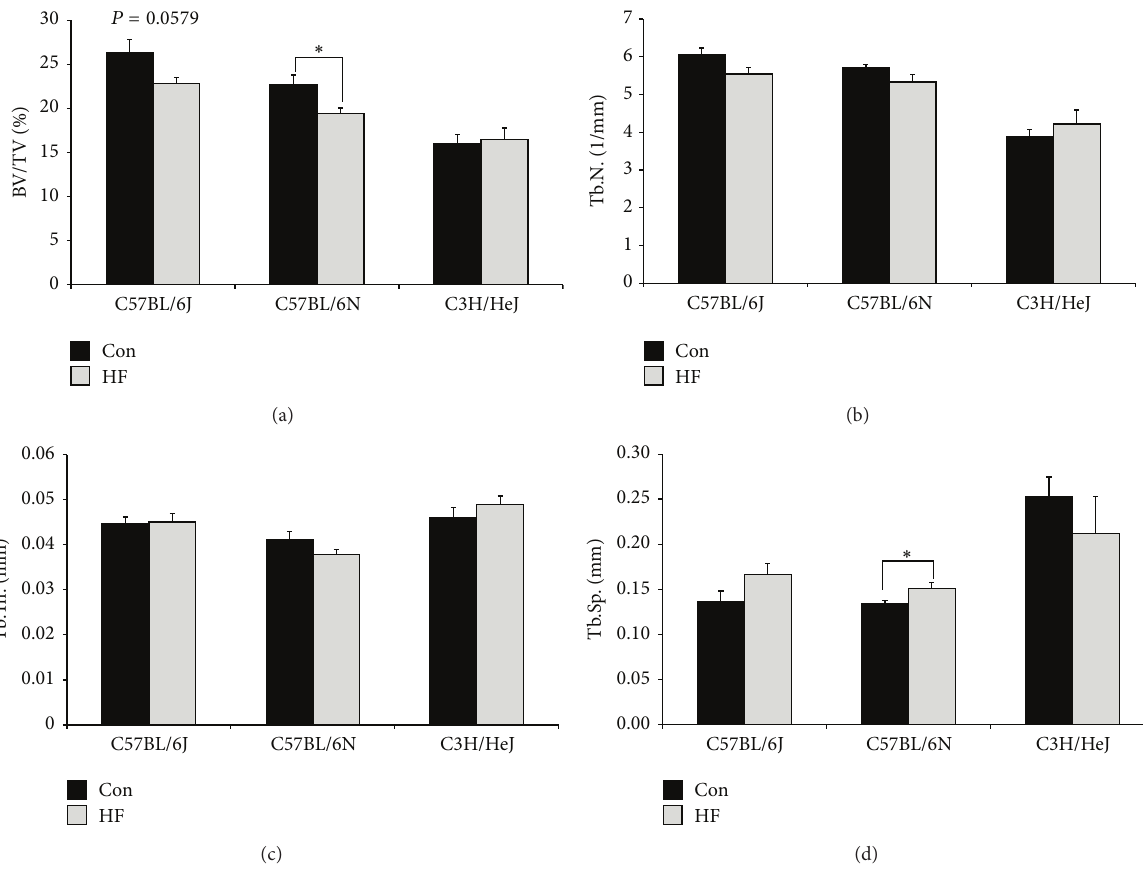
Figure 6: Micro-CT analyses of trabecular bone in the lumbar vertebra (L4) in C57BL/6J, C57BL/6N, and C3H/HeJ mice on a control (Con; AIN-93M) or a high fat diet (HF; 45% kcal from fat) for 24 wk. Parameters include (a) bone volume/total volume (BV/TV), (b) trabecular number (Tb.N.), (c) trabecular thickness (Tb.Th.), and (d) trabecular separation (Tb.Sp.). Symbol, ∗ , represents a significant difference ( 𝑃 < 0.05 ) between dietary treatments for a given strain.